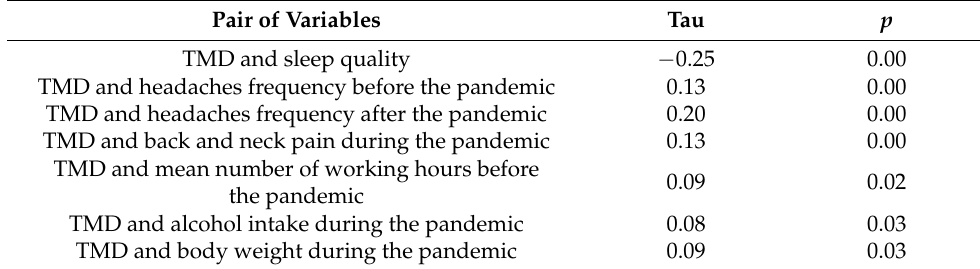
Table 10. Correlation between TMD intensity and other associated factors. Pair of Variables Tau